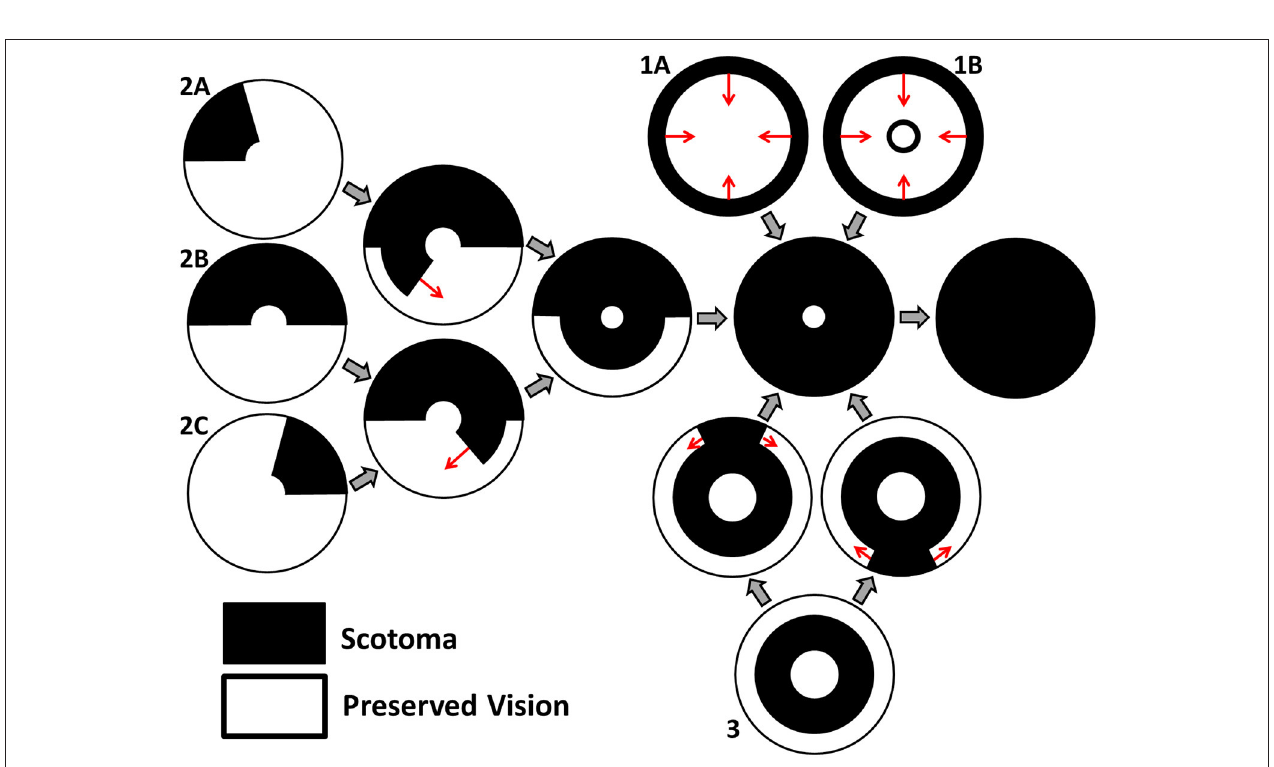
FIGURE 2 | Characteristic patterns of visual field loss in human RP (reproduced, with permission, from Roberts et al., 2018). Visual field loss patterns can be classified into three cases and six subcases (classification system described in Grover et al., 1998). Large gray arrows indicate transitions between stages of visual field loss and small red arrows indicate the direction of scotoma (blind spot) propagation. See text for